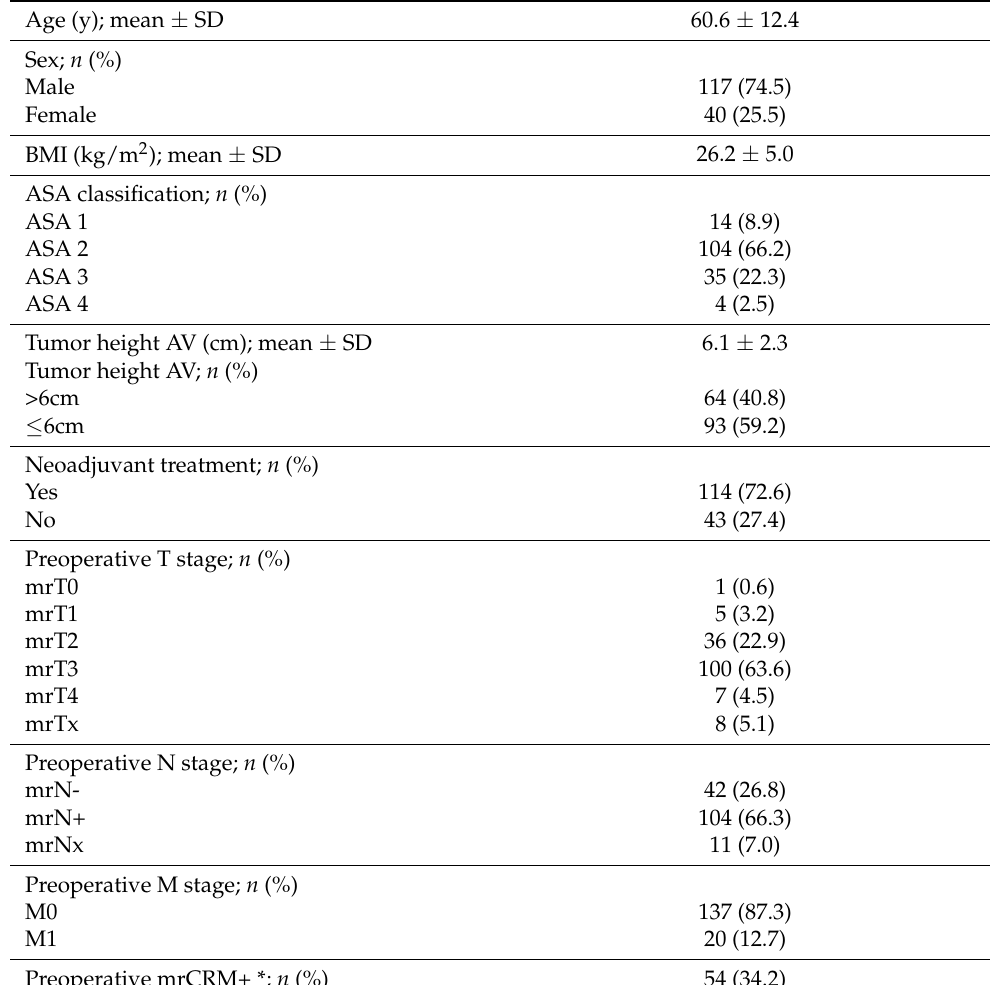
Table 1. Patient characteristics ( n =